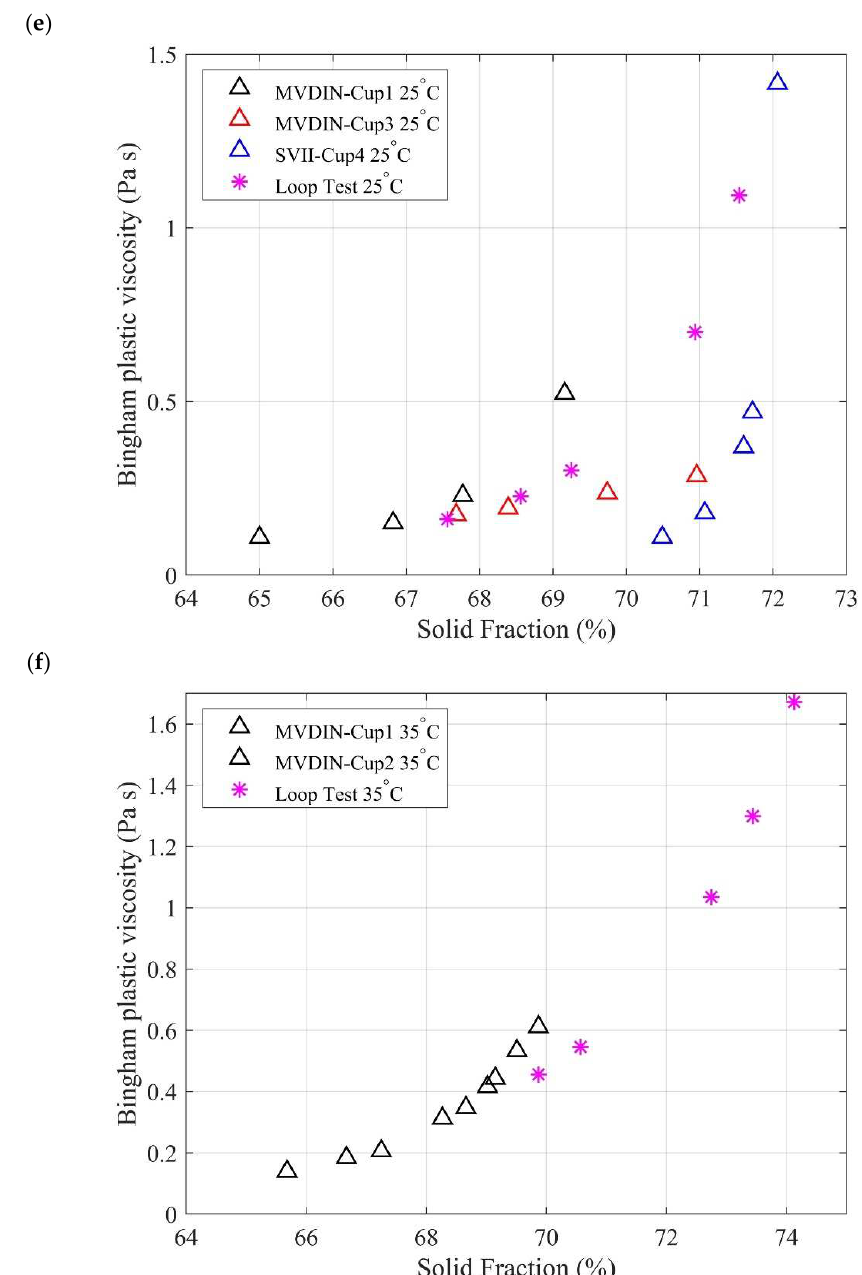
Figure 8. Bingham plastic viscosity for ( a ) Mine-A at 15 °C; ( b ) Mine-A at 25 °C; ( c ) Mine-A at 35 °C; ( d ) Mine-B at 15 °C; ( e ) Mine-B at 25 °C; and ( f ) Mine-B at 35 °C. Tailings are the larger component in paste backfill and their influence on rheology is by PSD. The characterization of paste backfill from different mines is unique because of PSD, tailings mineralogy, history of mineral processing, and intended application [51,52]. Along with PSD, particle surface area and density strongly affect the yield stress and apparent viscosity of a fluid [53]. The rheological behavior of paste backfill is highly dependent on PSD and, in particular, the fraction of particles under −20% µm (Fall et al., 2005). A minimum of 15% < 20 µm is necessary to create paste properties [54]. Very fine tailings are generally mixed with aggregates such as sand to alter the PSD to achieve desirable rheological properties and strengths. These factors determine the design of paste backfill mixing, distribution, and transport